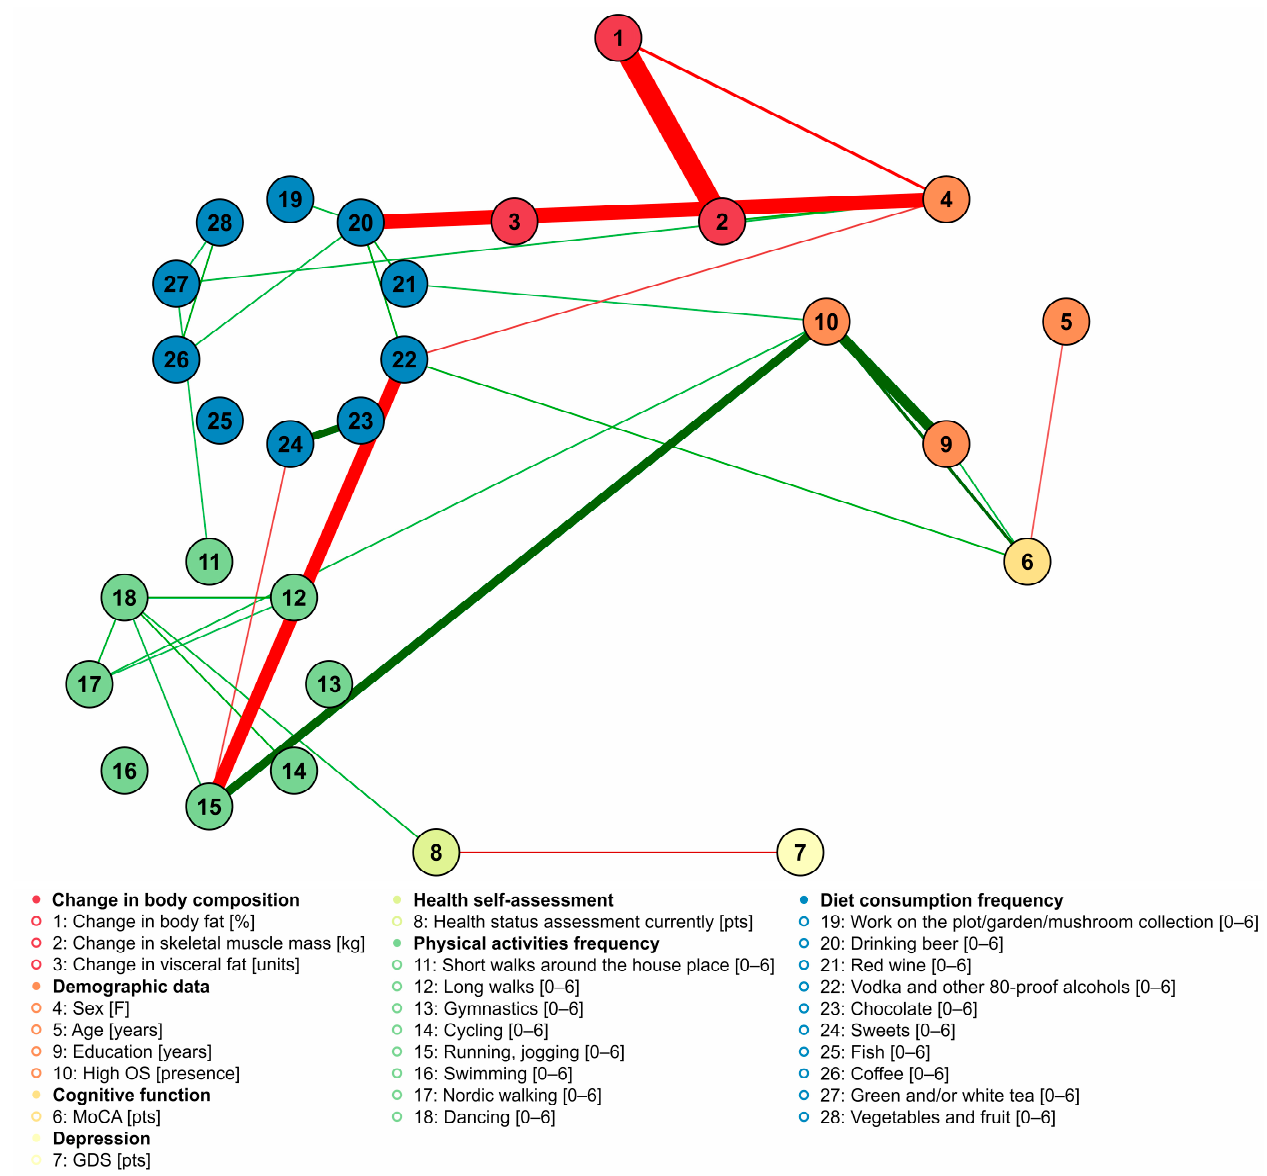
Figure 3. Network analysis of the relationship of body composition change with the frequency of physical activities, food products consumption, demographic data, cognitive function, depression severity, and health self-assessment. Nodes were grouped according to pre-specified groups, to which each variable belongs. Illustrated graphs are weighted, with green edges showing positive weights and red edges showing negative weights. The color saturation and the width of the edges are proportional to the absolute weight and scale relative to the strongest weight in the graph. OS—